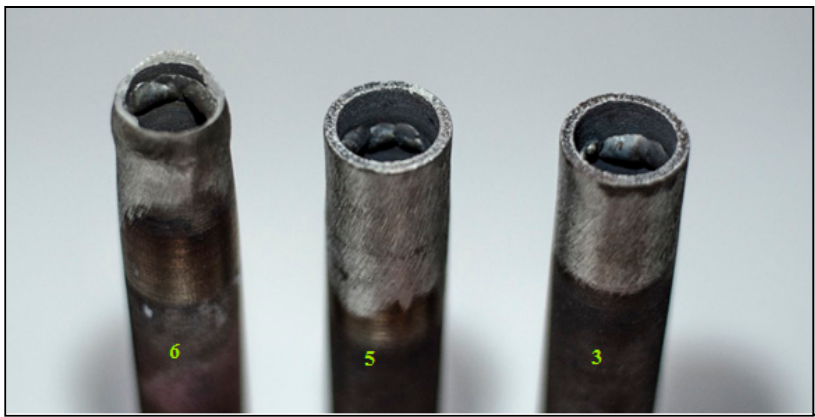
Figure 13. Test specimens after tensile test from the left: sample No. 6, No. 5 and No. 3.